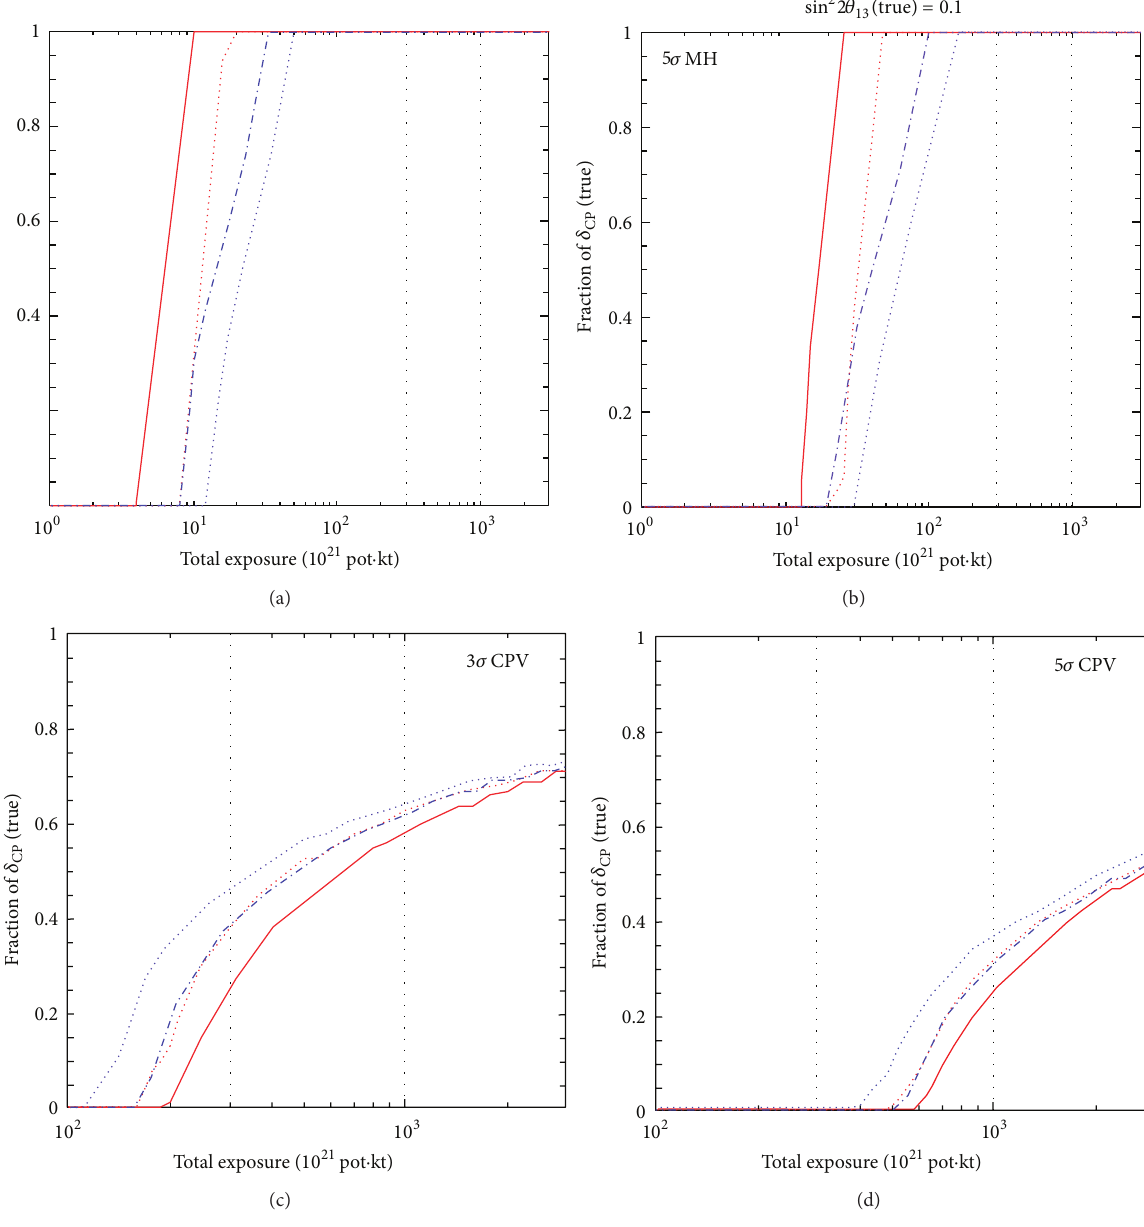
Figure 12: CP fraction for which a mass hierarchy (upper plots) and CP violation (lower plots) discovery at 3𝜎 (left) and 5𝜎 (right) is possible as a function of exposure for a staged LAGUNA setup. The different lines correspond to true normal (inverted) hierarchy for solid (dashed) lines and for a baseline of 2290 km (1540km) for red (blue) lines. Figure is taken from [112] where more details about the simulations can be